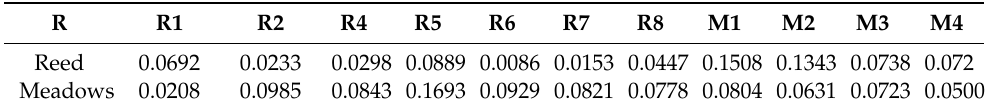
Table 8. The SAM values between the individual targets and the mean spectra of the two classes. R1–R2 and R4–R8 represent reed bed targets and M1–M4 represents meadow targets. R